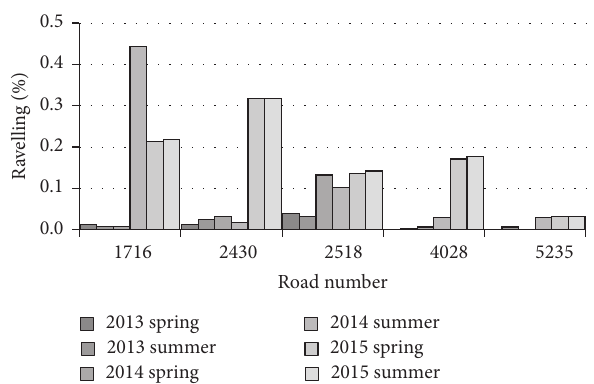
Figure 9: Ravelling on roads sections covered with soft asphalt.